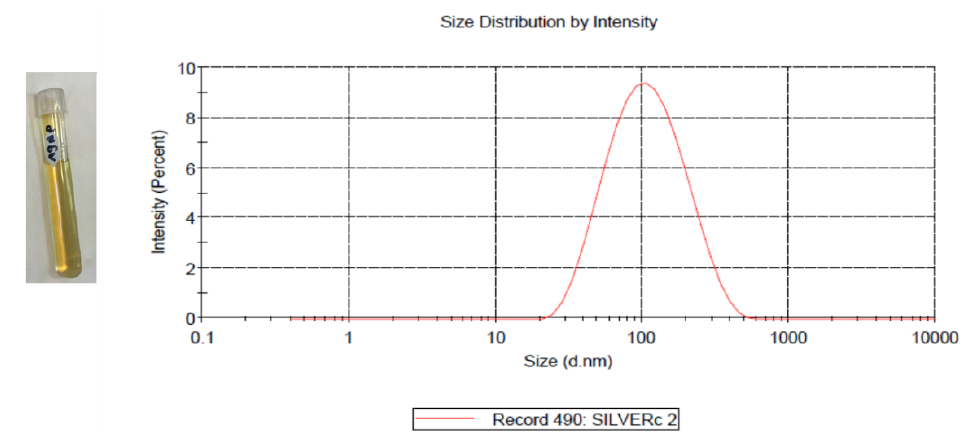
Figure 1. Prepared AgNPs ( left ); the average size AgNPs was 80 nm with a single peak at 123.5 nm, as measured by DLS ( right ).